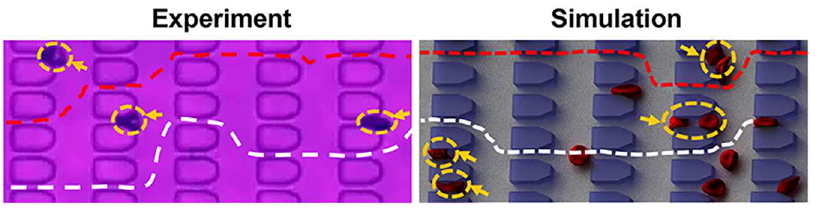
Fig 4. Trajectories of deformable sickle cells flowing in microfluidic channels. Each line shows the trajectory of individualdeformable sickle RBCs in microfluidic channelflow. Arrows indicatethe trapped sickle RBCs at the